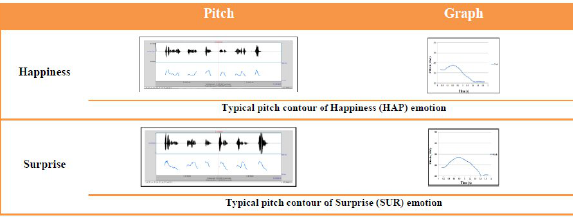
Fig. 3. European pitch contours for Happiness and Surprise.